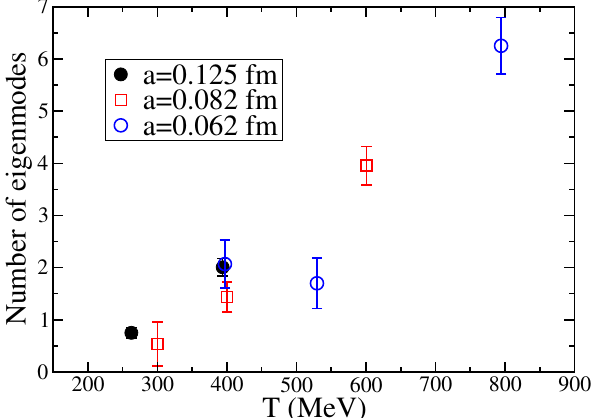
Figure 13. Density of localized modes (modes per cubic fermi) in high-temperature QCD. From Ref. [33]. (Reprinted figure with permission from T.G. Kovács and F. Pittler, Phys. Rev. D 86, 114515 (2012). Copyright (2012) by the American Physical Society).